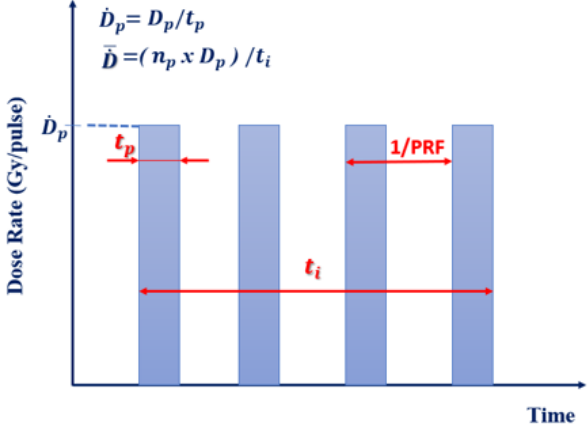
Figure 1. Typical time structure of electron beam